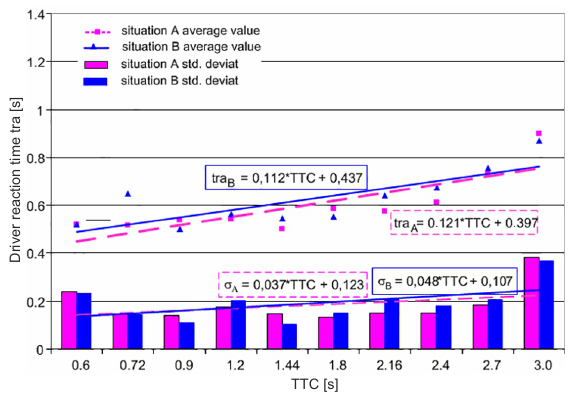
Fig. 12. The values of obtained reaction times on the accelerator pedal – tra